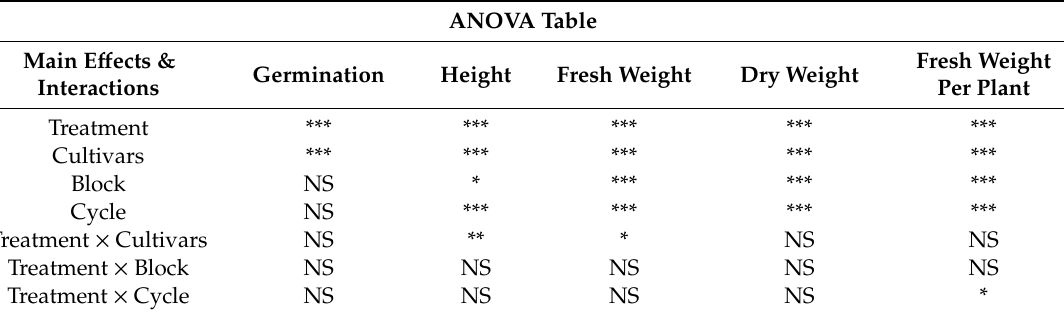
Table 7. Analysis of Variance for seed size